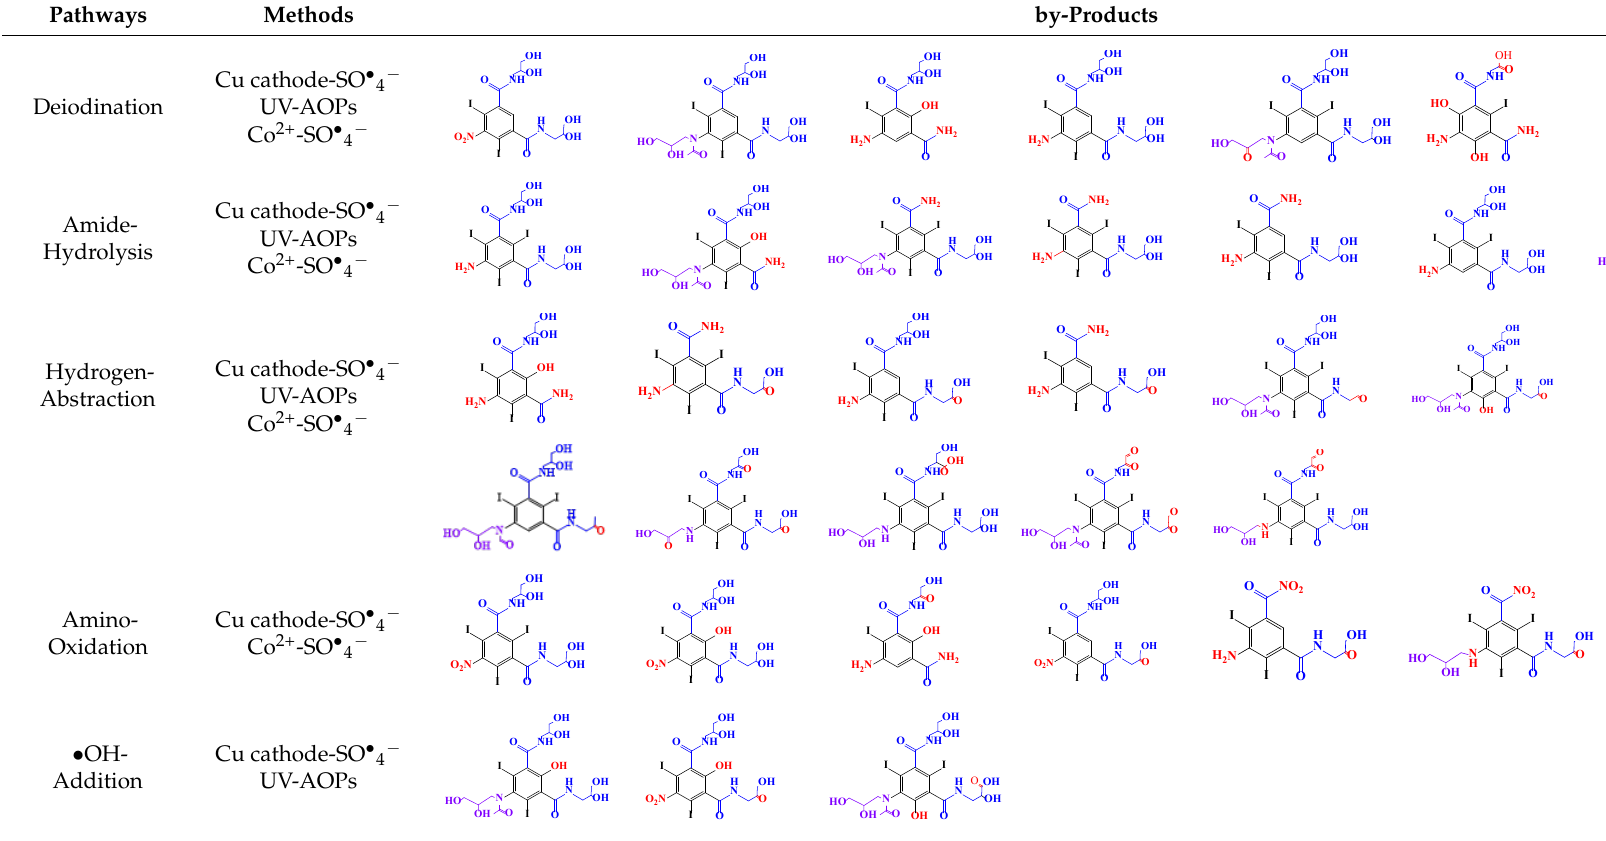
by-Products Ref.